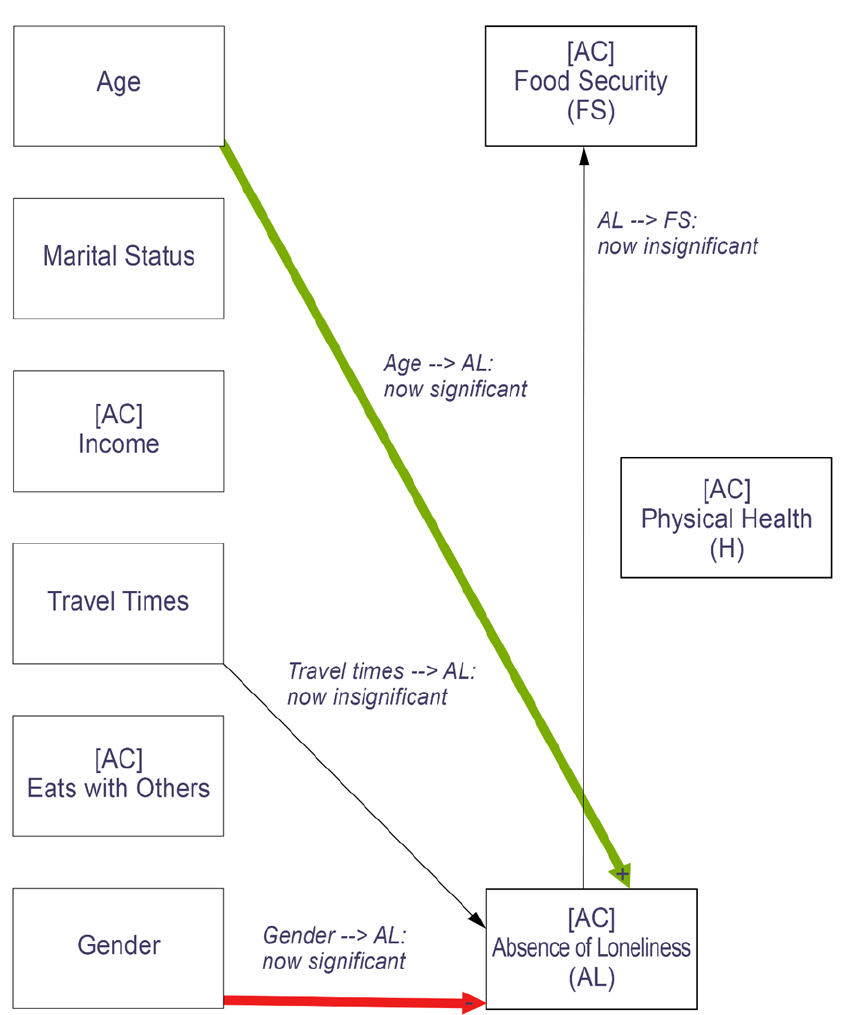
Figure 2. Path analysis results showing the differences in relationships after the onset of COVID-19 compared to the before-COVID path analysis. Thick lines represent significance at α = 0.05. Thin lines represent insignificance. Green represents positive relationships and red negative